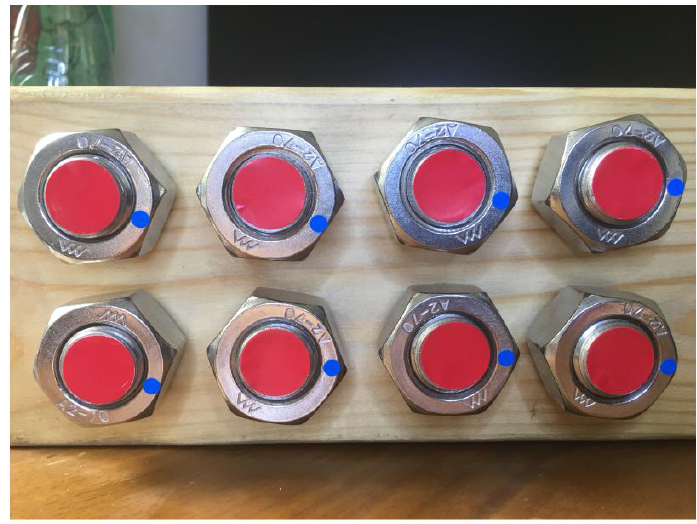
Figure 16. Eight-bolted connection.